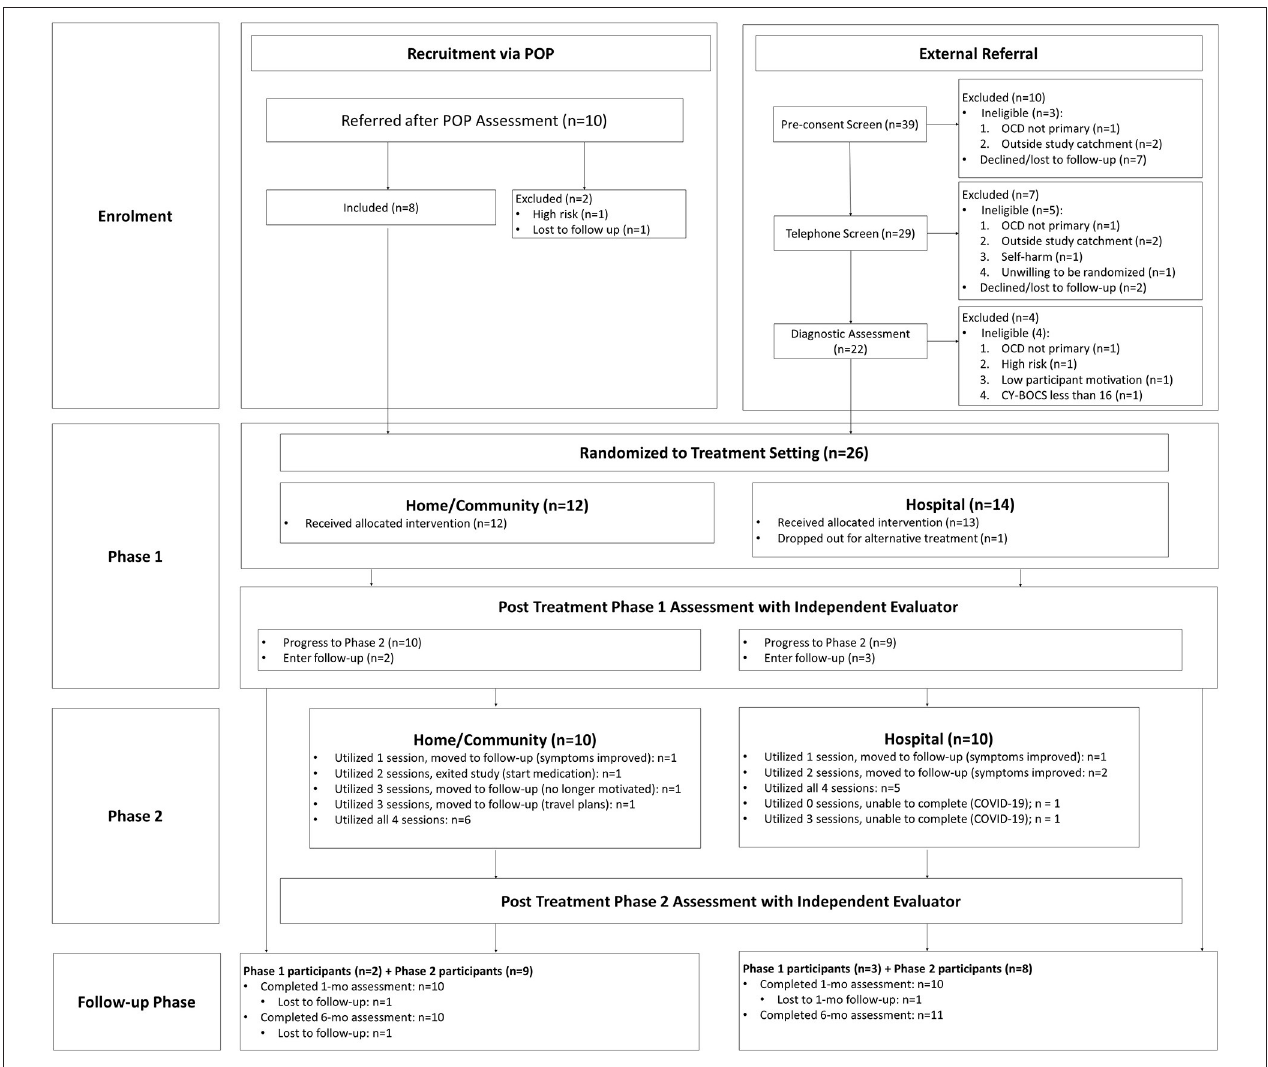
FIGURE 1 | Flow chart of participants through study